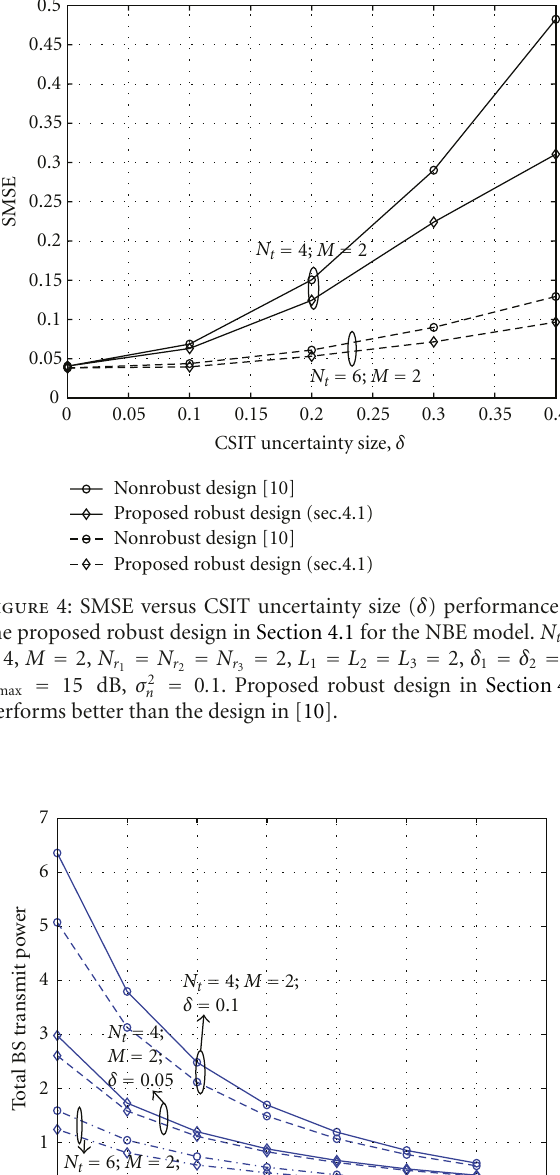
= N r = 2, L = L = 2, CSIT 1 2 1 2